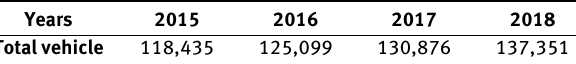
Table 1: Vehicle in Bielsko-Biala county [17] Table 2: Descriptive statistics of data set